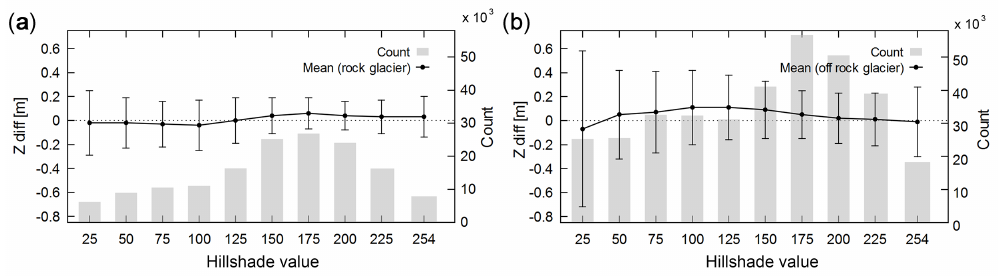
Figure 16. Elevation differences between 2014 SfM–MVS and ALS-based DEMs calculated for hillshade value intervals of 25 (a) in the rock glacier reconstructed area and (b) in the bare ground outside the rock glacier. Lowest values represent shadowed area, whilst well-lit areas have the highest